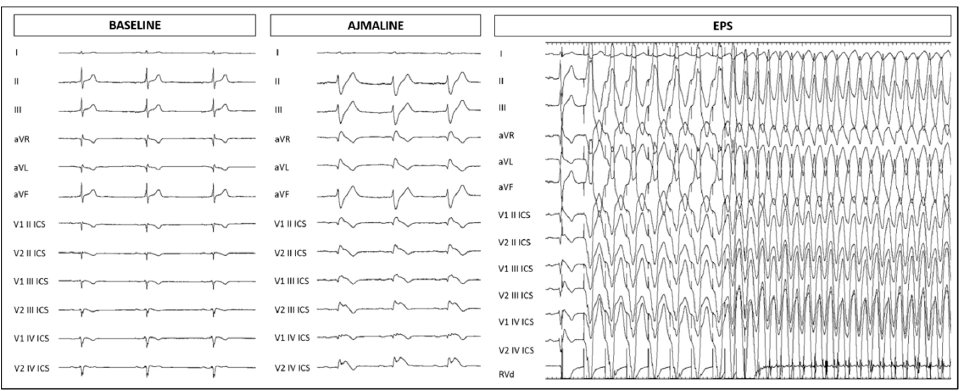
Figure 2. Electrocardiogram at baseline, after ajmaline administration, and ventricular tachycardia/ventricular fibrillation inducibility during electrophysiological study for proband. Int. J. Mol. Sci. 2019 , 20 , x FOR PEER REVIEW Genetic testing of several genes described in BrS research literature ( ABCC9, AKAP9, CACNA1C,